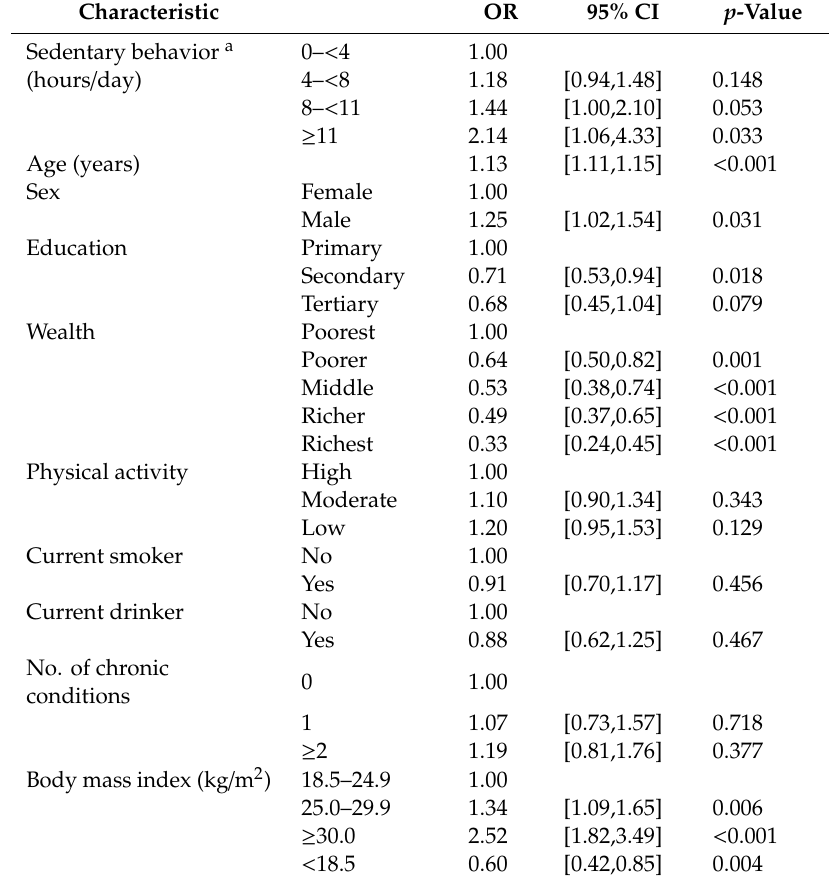
Table 2. Association of sedentary behavior and covariates with sarcopenia, estimated by multivariable logistic